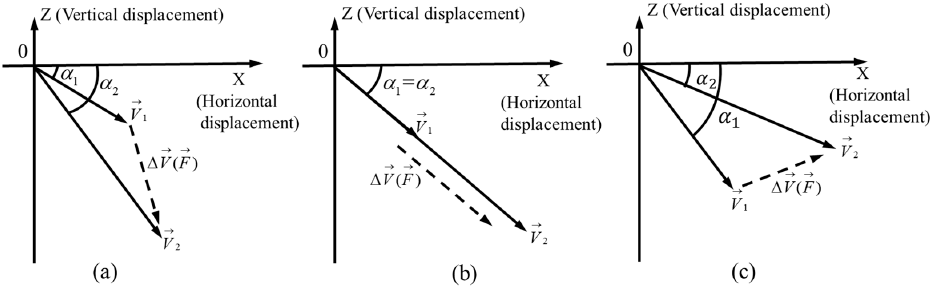
→ → F . ( a ) ∆ α > 0 and ∆ v > 0; ( b ) ∆ α = 0 and